Question: Name the type of graph shown.
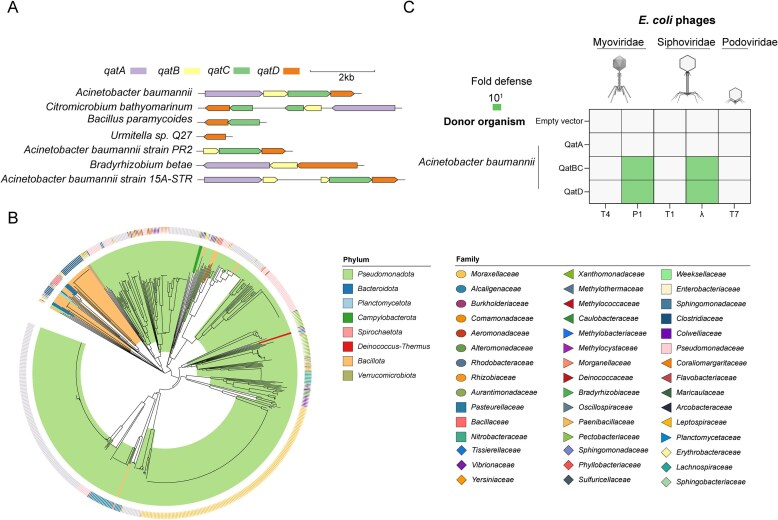
Answer: heatmap